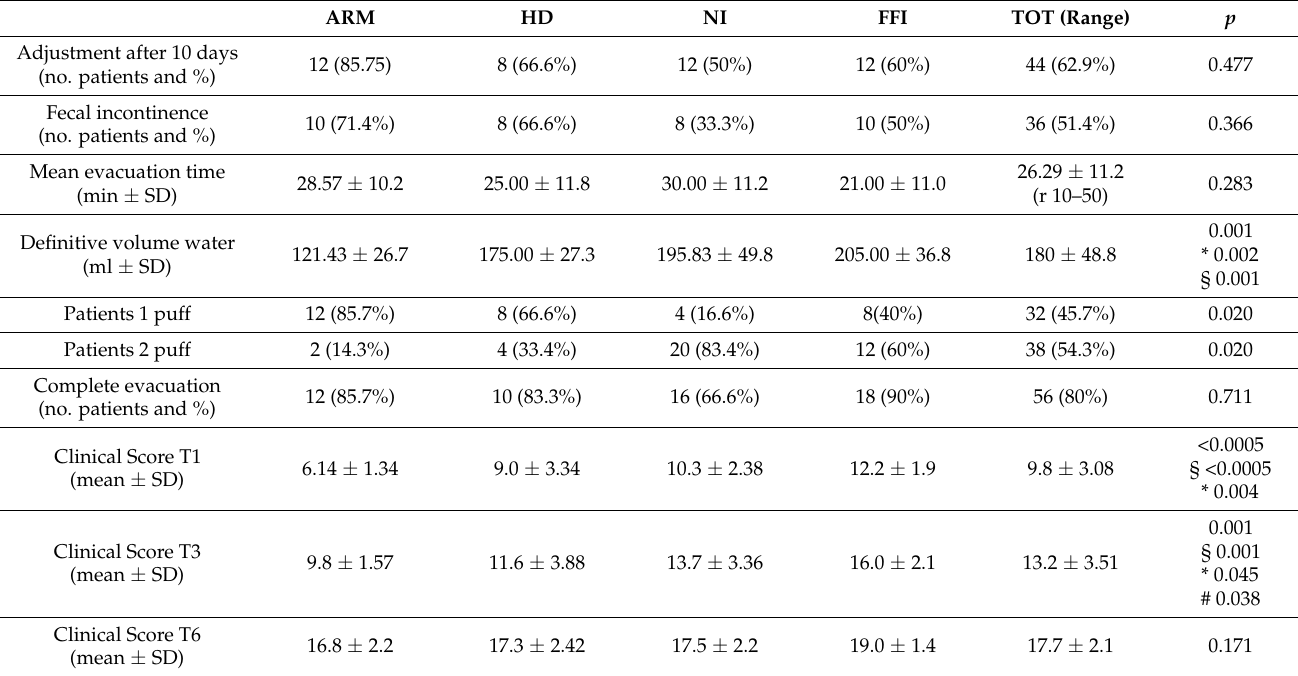
Figure 2. Volumetric enema with contrast until left colon. Table 2. Treatment outcome for each group.